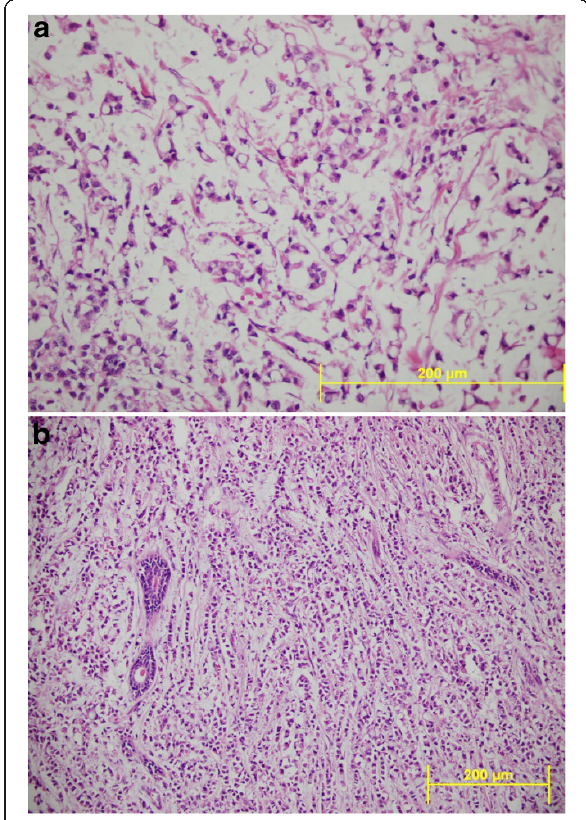
Figure 5 a)Signet ring cells with distended bubbly cytoplasm and distinct intracytoplasmic lumens and abundant extracellular mucin were seen. (HEX400) b ) Tumor showing indian-file pattern in some area. (HEX200).